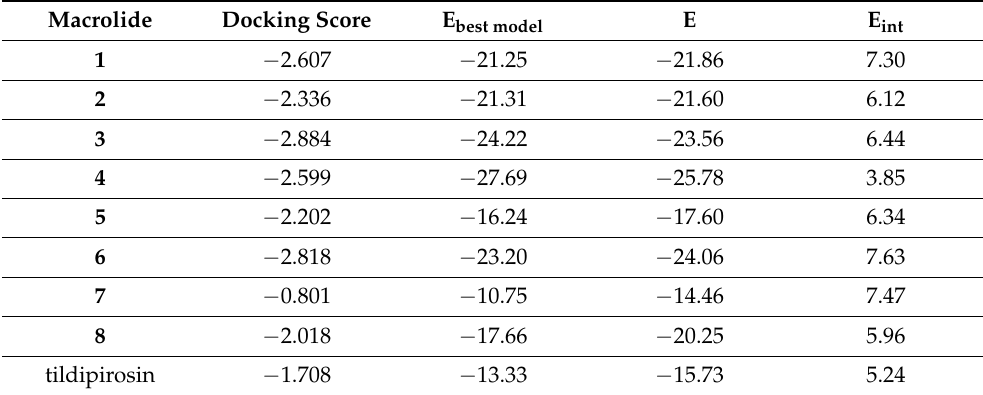
Table 3. Docking scores of selected macrolides to the narrow region around amino acids Lys 90 and Arg 92 of protein chain B from 70S E. coli